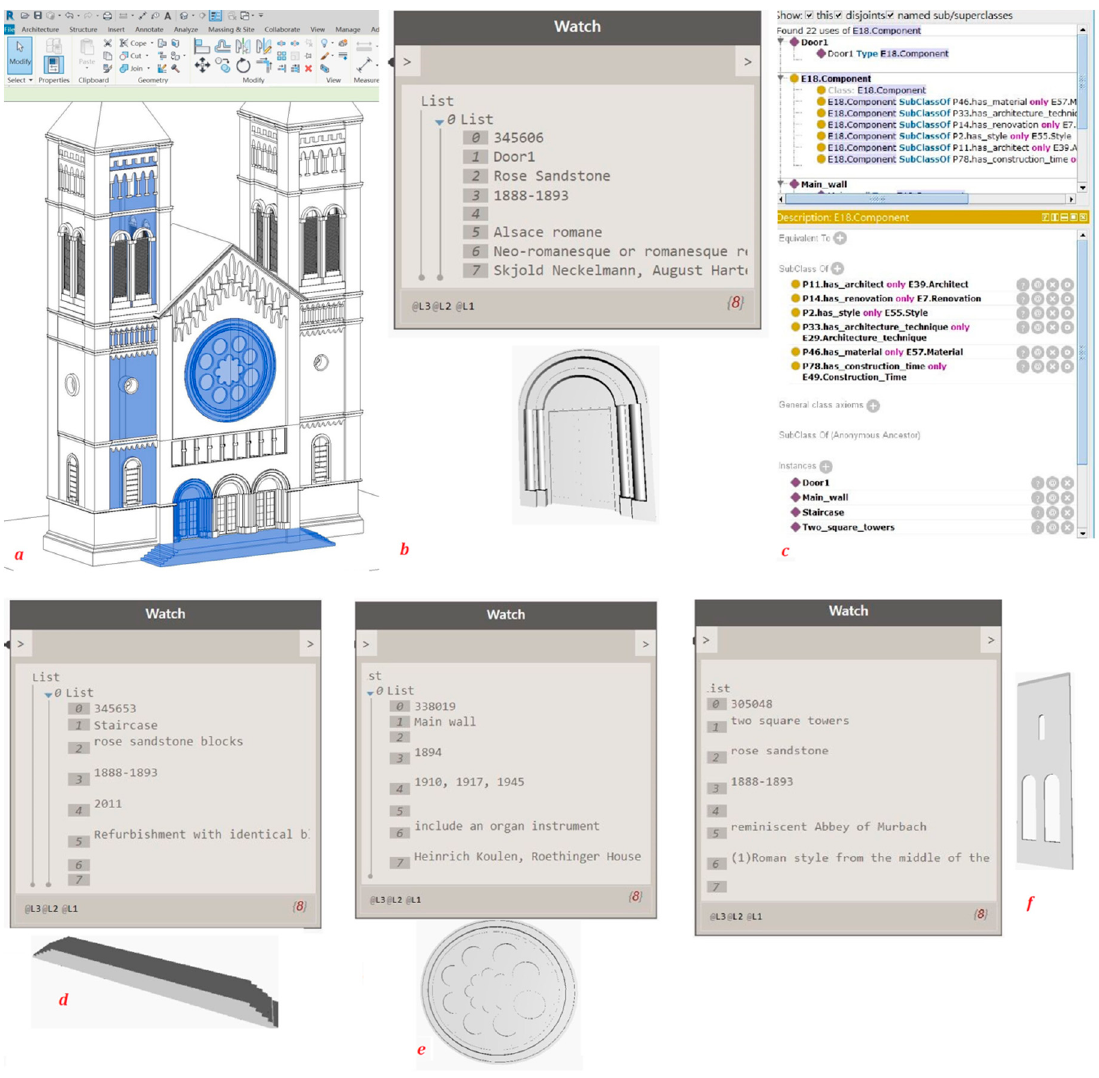
Figure 11. The browsing result of some heritage components in Dynamo with geometry and knowledge. The “ watch ” window ( b , d , e , f ) in the Dynamo interface can display the knowledge of selected element of HBIM model ( a ) in the Revit platform. The knowledge in “ watch ” window derives from previously defined knowledge model ( c ).